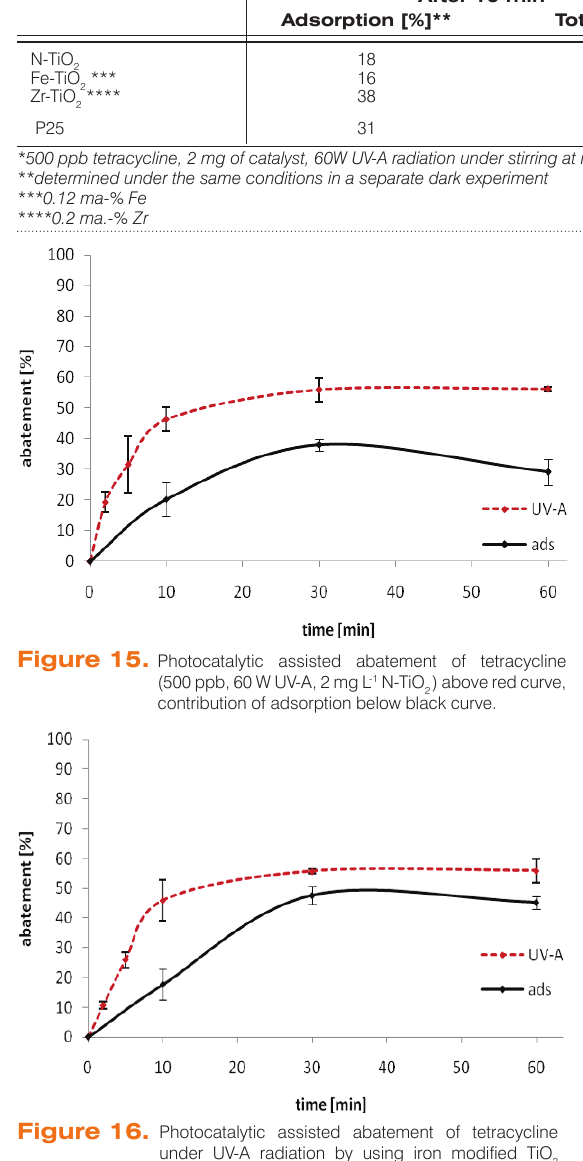
Table 1. Photocatalytic abatement of low concentrated tetracycline with different titania catalysts under UVA radiation. Catalyst Abatement of tetracycline during treatment* After 10